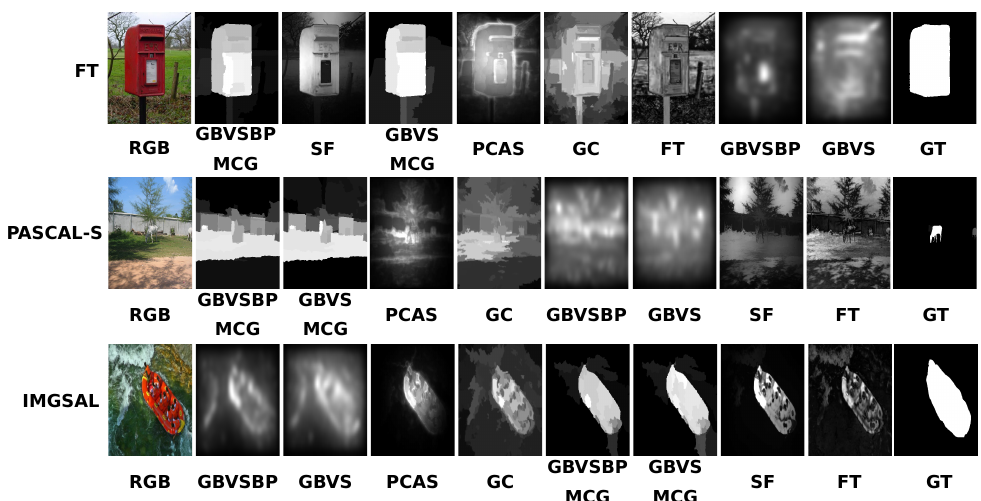
Figure 4. Example of maps obtained in experiments whose results are controversial despite that our models observe better performance in the benchmark. The FT image shows the relevance of the segmentation process to rank highest in the benchmark. The PASCAL-S image shows a misleading ground truth that confuses all algorithms. Finally, the IMGSAL image shows a reasonably well- segmented image that contrasts with all others in the dataset, generating a controversial result.